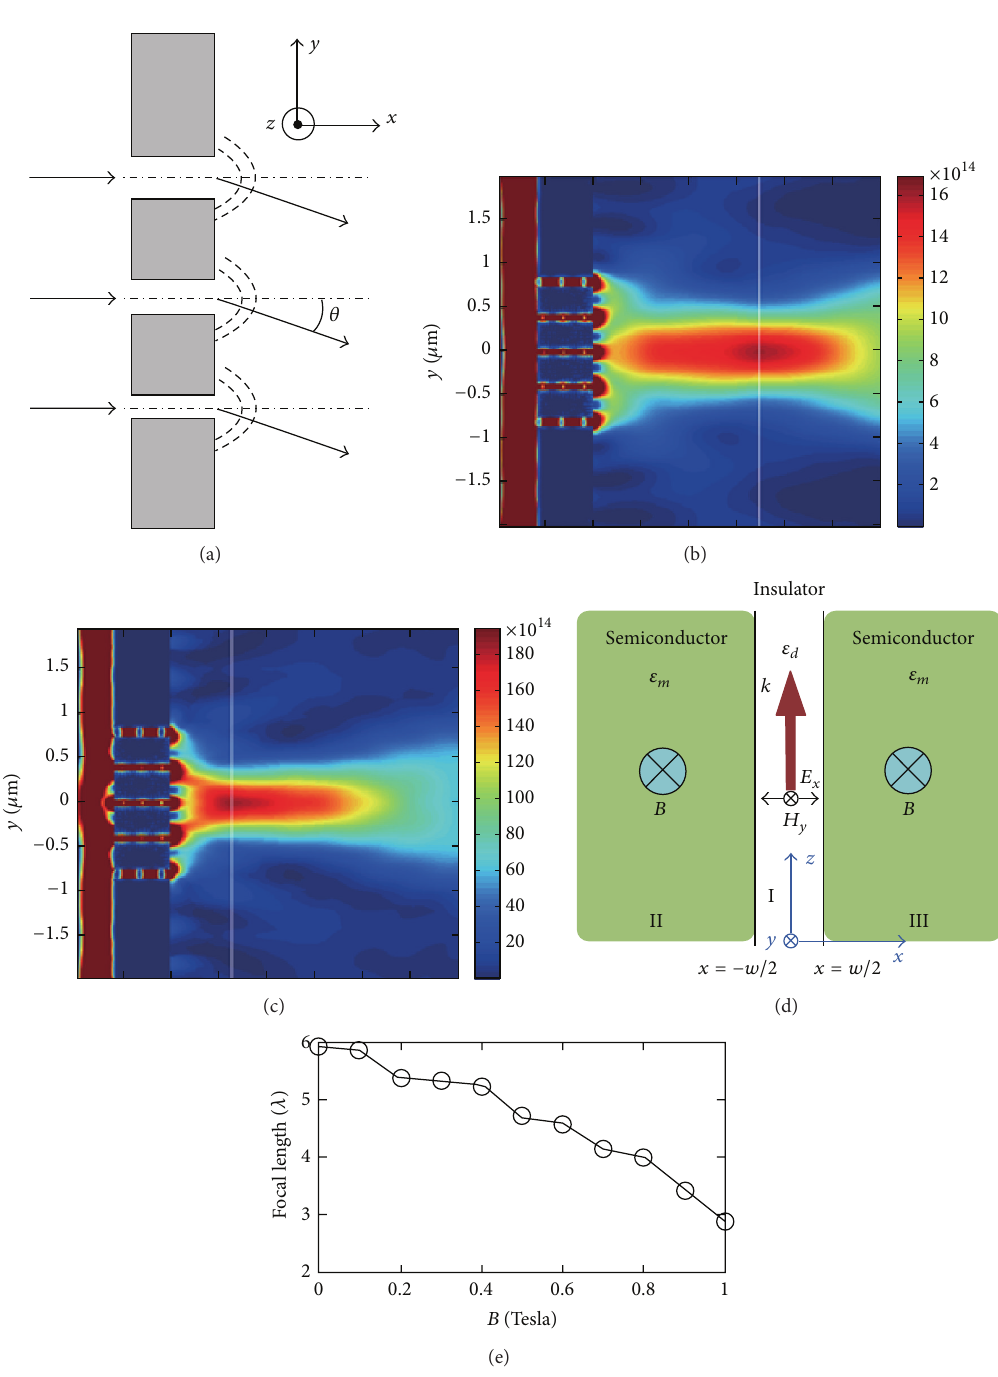
Figure 23: (a) Schematic view of the three-slit structure under study. (b) and (c) The FDTD simulation of electric field intensity |𝐸| 2